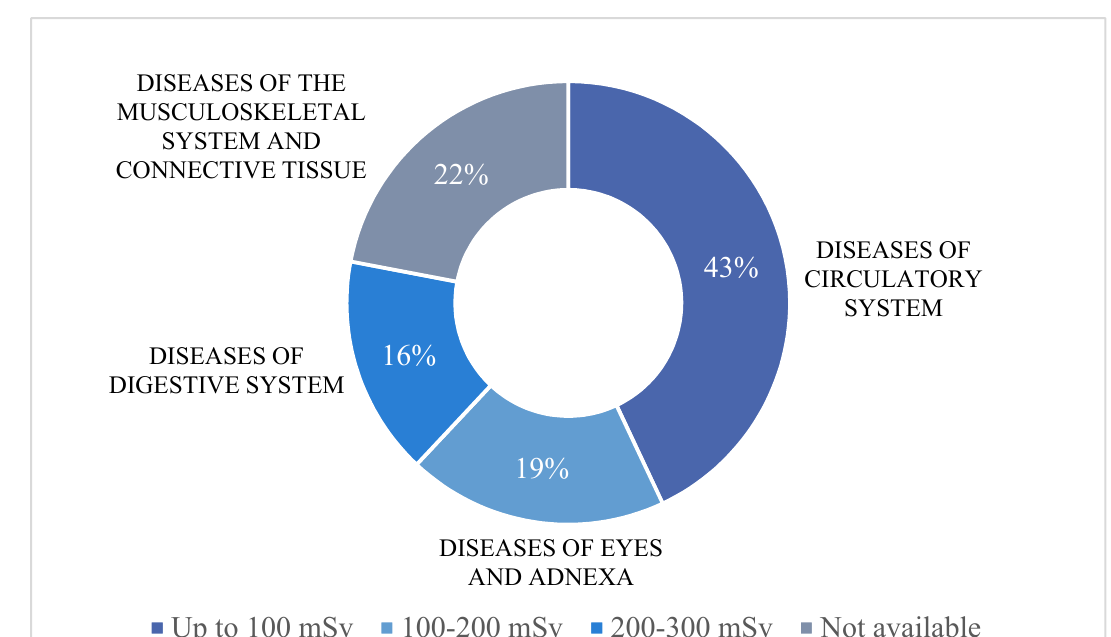
Figure 2. The most common disease groups in the cohort of the LCWC according to IR dose. A significant percentage of participants (43%; 40 of 93 participants) in the cohort of the LCWC experienced IR doses up to 100 mSv. Diseases of the circulatory system predominated in this group. Of the LCWC, 19% (18 of 93 participants) experienced IR doses of 100–200 mSv, with eye and adnexa diseases being the most common in this group. Diseases of the digestive system predominated in the group of the LCWC with IR doses of 200–300 mSv (16%; 15 of 93 participants). In the LCWC group, information about the dose of IR was not available (22%; 20 out of 93 participants), and diseases of the musculoskeletal system and connective tissue were the most common.